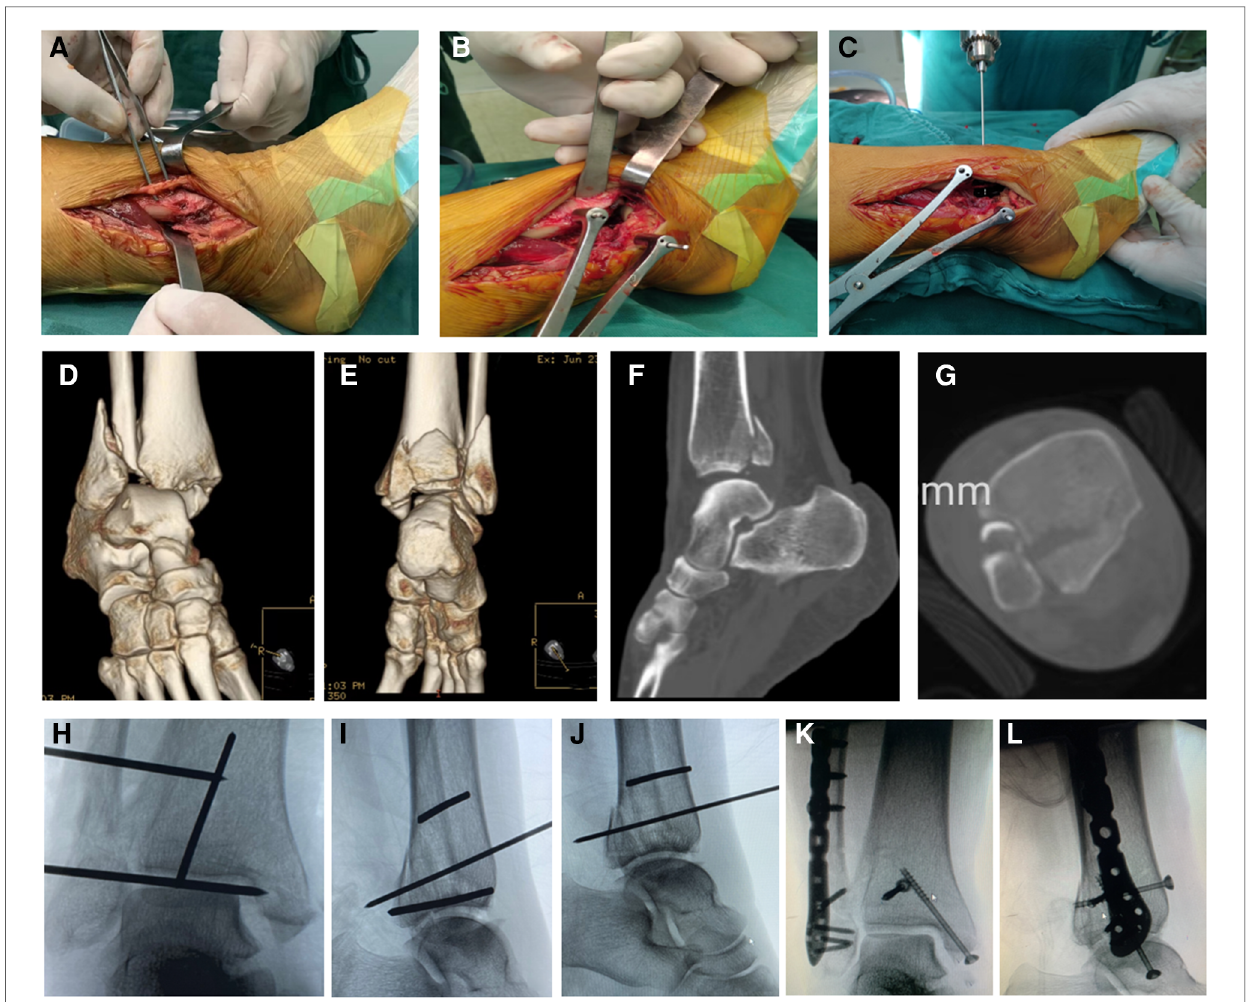
FIGURE 1 Surgical procedure of a single lateral approach via stretching fi bular fracture line. ( A ) A single lateral incision was used to expose the broken end of the fi bula fracture. ( B ) The ankle joint was distracted with a Hintermann retractor to obtain suf fi cient working space. ( C ) A hollow guide needle was inserted from the anterior tibia to the posterolateral tibia to fi x the posterior malleolus fracture. ( D,E ) Preoperative 3D reconstruction images. ( F ) Preoperative sagittal CT image. ( G ) Preoperative transverse CT image. ( H ) Intraoperative anterior – posterior x-ray image showed the fi xation of the fracture with Kirschner wires. ( I ) Intraoperative lateral x-ray image showed the fi xation of the posterior malleolus fracture with the Kirschner wire and the fracture reduction was mildly poor. ( J ) After adjustment, anatomic reduction with the Kirschner wire. ( K ) Postoperative anterior – posterior x-ray image. ( L ) Postoperative lateral x-ray